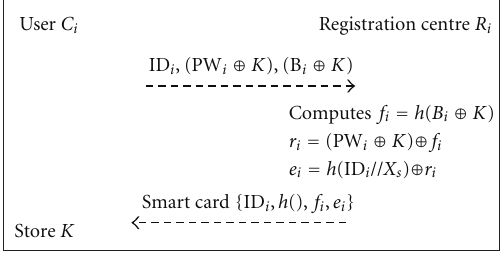
Figure 2: Registration phase of the enhanced